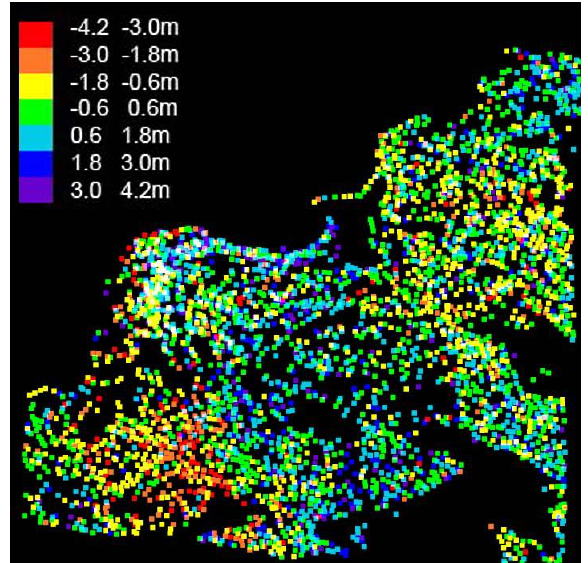
Figure 16. Differences in height between DSM 283-284 and reference DTM